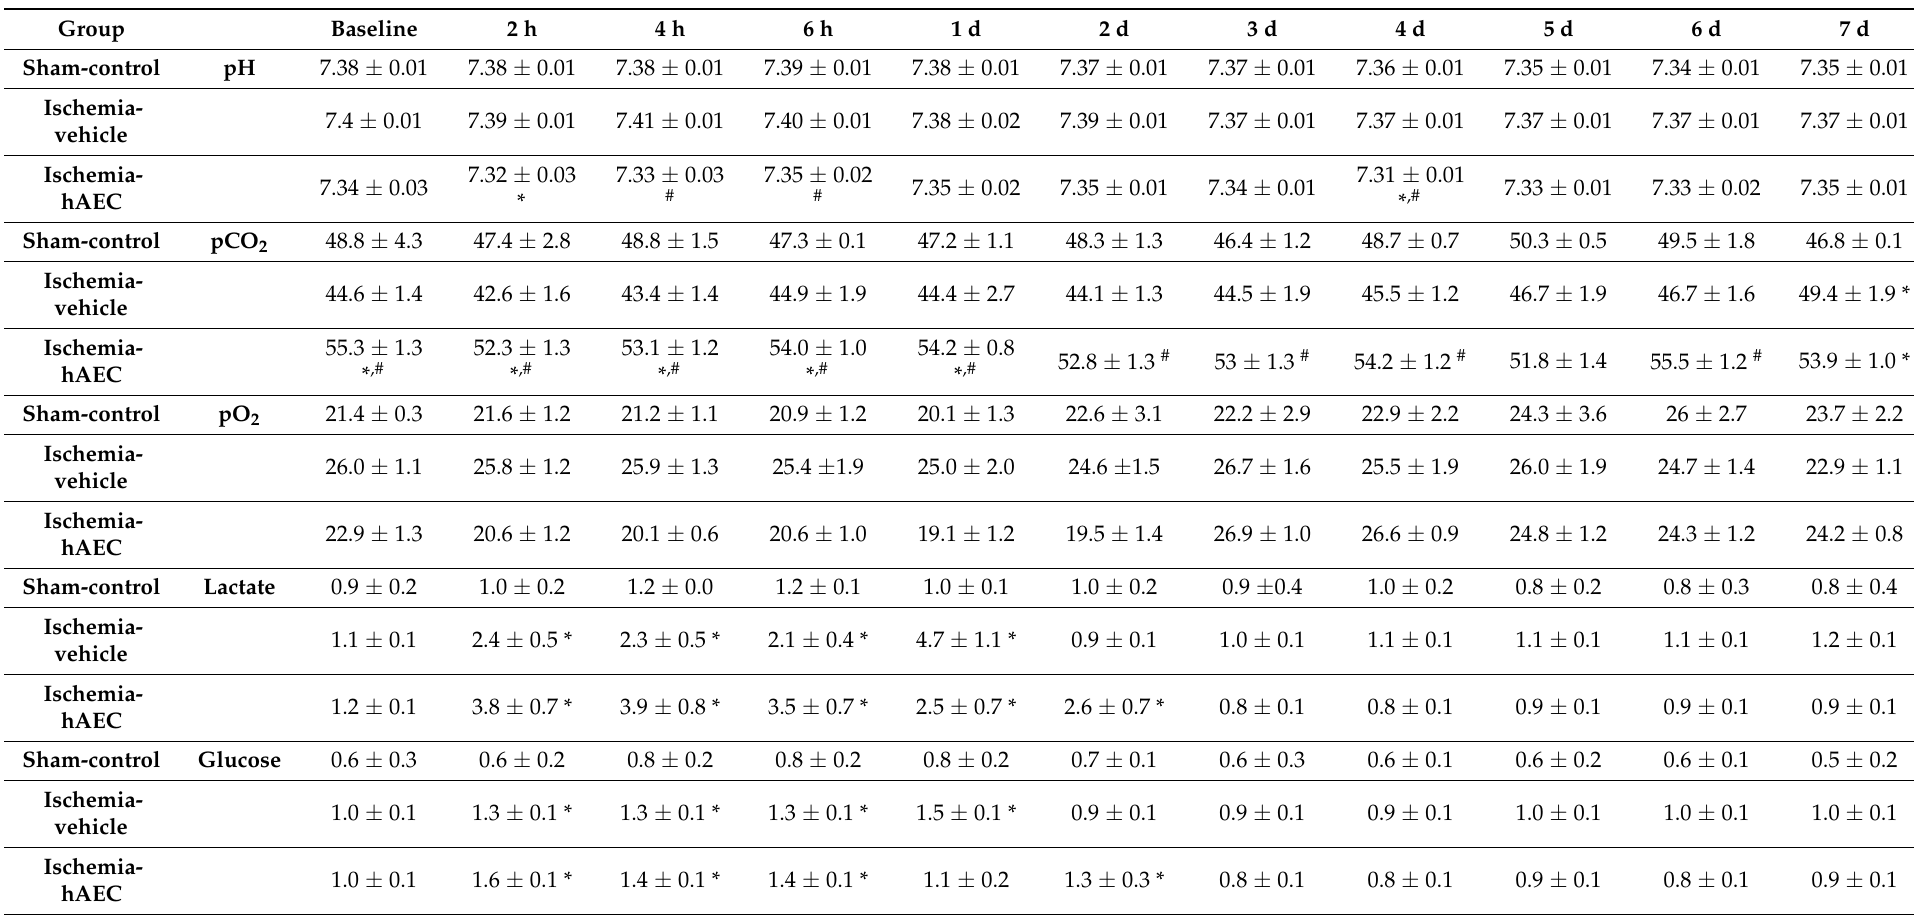
Table 2. Blood gas, glucose and lactate concentration before, 2 h, 4 h and 6 h after ischemia, followed by daily until day 7 in near term fetal sheep in the sham control (n = 8), ischemia-vehicle (n = 7) and ischemia-hAEC groups (n = 6). * p < 0.05 versus sham control, # p < 0.05 versus